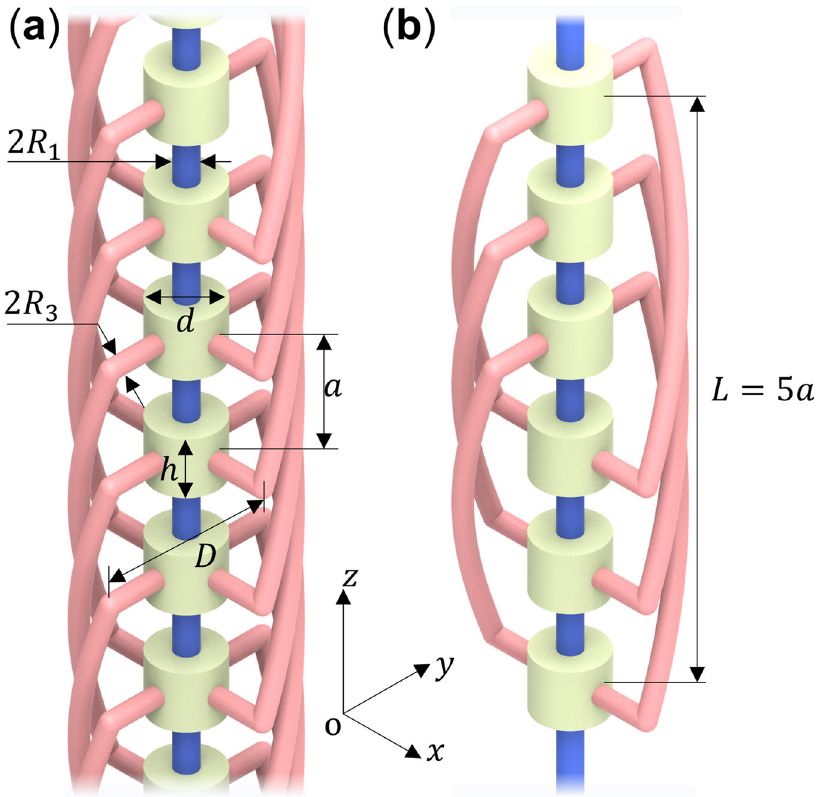
Fig. 8 Illustration of the considered 3D acoustical metamaterial for airborne sound. a In fi nite periodic metamaterial with non-local interactions. The metamaterial is composed of acoustical cavities (yellow cylinders) and acoustical channels (blue and red pipes). Colors are for illustration only, all parts represent voids for air. The yellow cylinders, with height h and diameter d , correspond to masses in the discrete mass-and-spring model, and the blue (red) pipes, with diameter 2 R 1 (2 R 3 ), represent the nearest-neighbor interactions (third-nearest-neighbor interactions). The helix part of the red pipes has a major radius, D = 2. b A speci fi c realization of the discrete model in Fig. 1b by using the metamaterial structure in a . The two semi-in fi nite pipes at both ends represent the surrounding. Therefore, the surrounding medium has no cut-off frequency, analogous to the effective-medium model shown in Fig. 6. Geometry parameters are: h ¼ 0 : 5 a , d ¼ 0 : 6 a , D ¼ 1 : 5 a , R 1 ¼ 0 : 1 a , and a ¼ 0 : 1 m, respectively. For air, we choose the sound velocity c air ¼ 343 m s (cid:2) 1 and the mass density ρ air = 1.29 kg m − 3